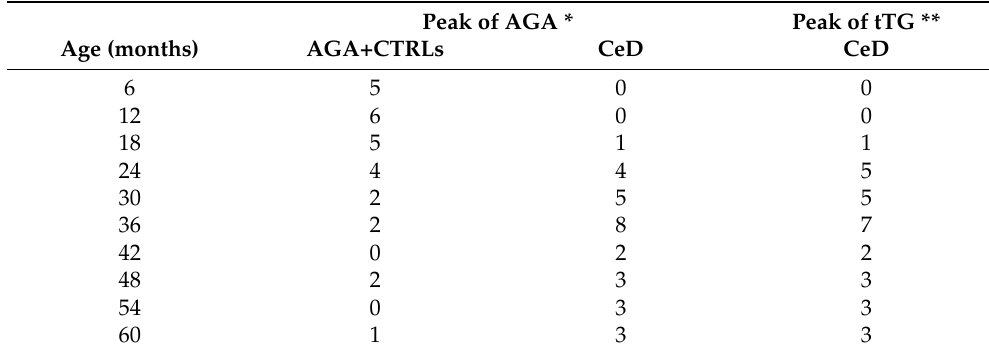
Table 1. Antibody production in controls with early production of AGAs and in celiac children. Peak of AGA * Peak of tTG ** Age (months)